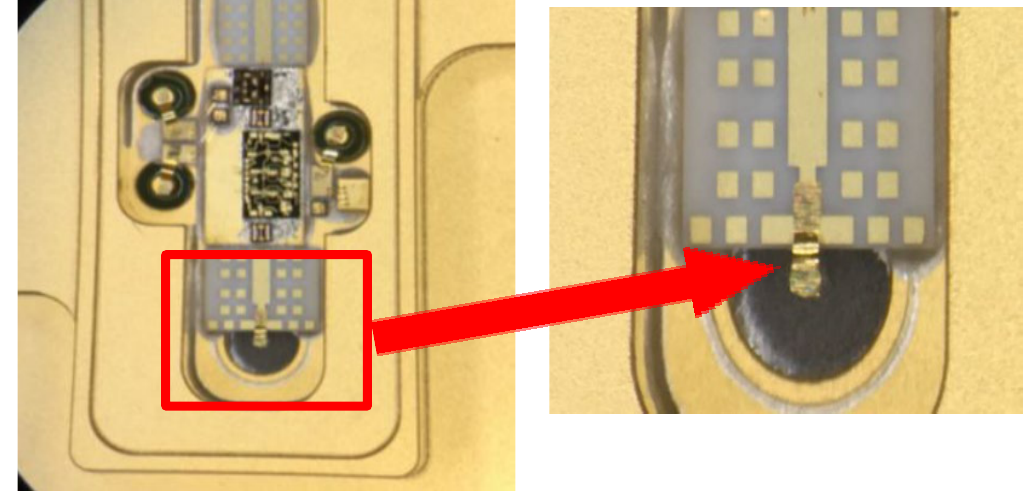
Figure 22. Actual photo of the vertical interconnection in the SIP.